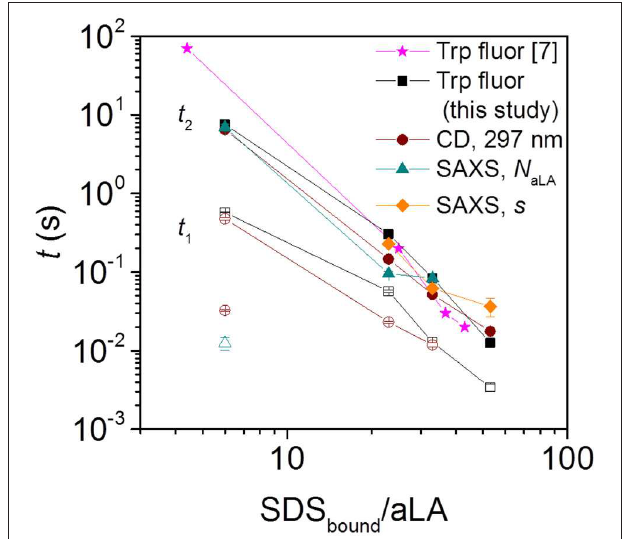
FIGURE 3 | Half times t 1 and t 2 for aLA unfolding and formation of surfactant-protein complexes, observed by Trp fluorescence, near-UV CD, and SAXS. Filled and empty symbols of the same kind (e.g., square) represent slow and fast phases associated with that technique (for squares this is Trp fluorescence). The SAXS half times are obtained from the time evolution of parameters describing the number of aLA molecules per complex, N aLA , and the offset of the protein shell around the micelle core, s . Note that the stoichiometries refer to the compositions of the SDS:aLA complexes [based on ITC values Otzen et al., 2009] rather than bulk ratios. For the smallest SDS total :aLA ratio of 9 (which leads to a ratio of 6 SDS:aLA in the protein complex), CD (brown empty circle) and N aLA values (cyan empty triangle) showed an additional fast exponential decay.